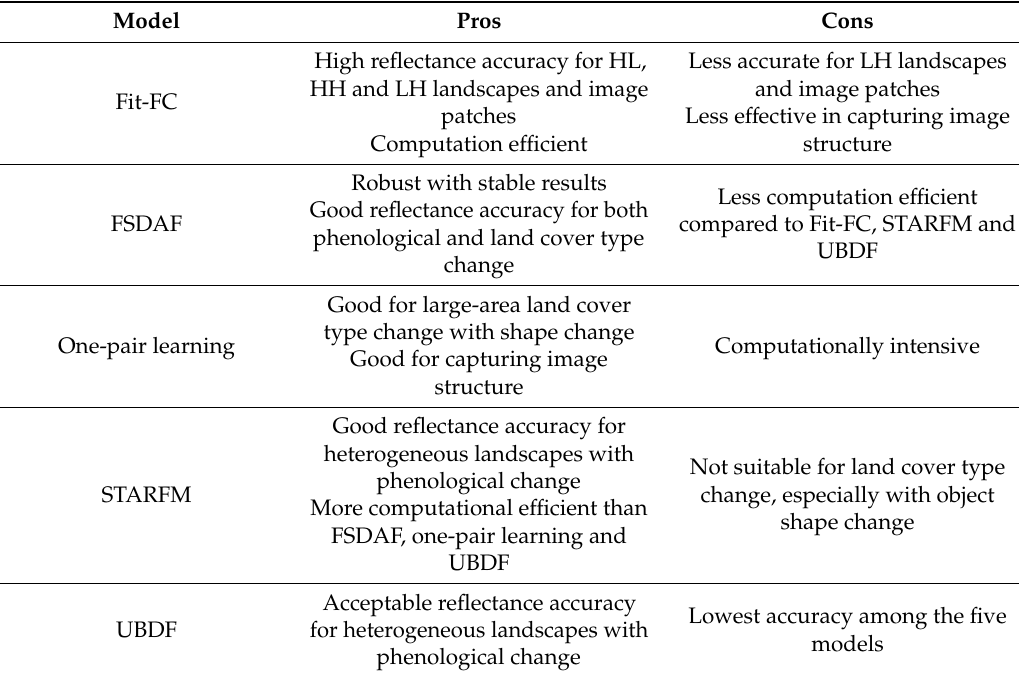
Table 4. Summary of pros and cons of the five models identified in this study. Model Pros Cons Less accurate for LH landscapes High reflectance accuracy for HL, and image patches HH and LH landscapes and image Fit-FC Less e ff ective in capturing image patches structure Computation e ffi cient Robust with stable results Less computation e ffi cient Good reflectance accuracy for both compared to Fit-FC, STARFM and FSDAF phenological and land cover type UBDF change Good for large-area land cover type change with shape change Computationally intensive One-pair learning Good for capturing image structure Good reflectance accuracy for heterogeneous landscapes with Not suitable for land cover type phenological change change, especially with object STARFM More computational e ffi cient than shape change FSDAF, one-pair learning and UBDF Acceptable reflectance accuracy Lowest accuracy among the five UBDF for heterogeneous landscapes with phenological change